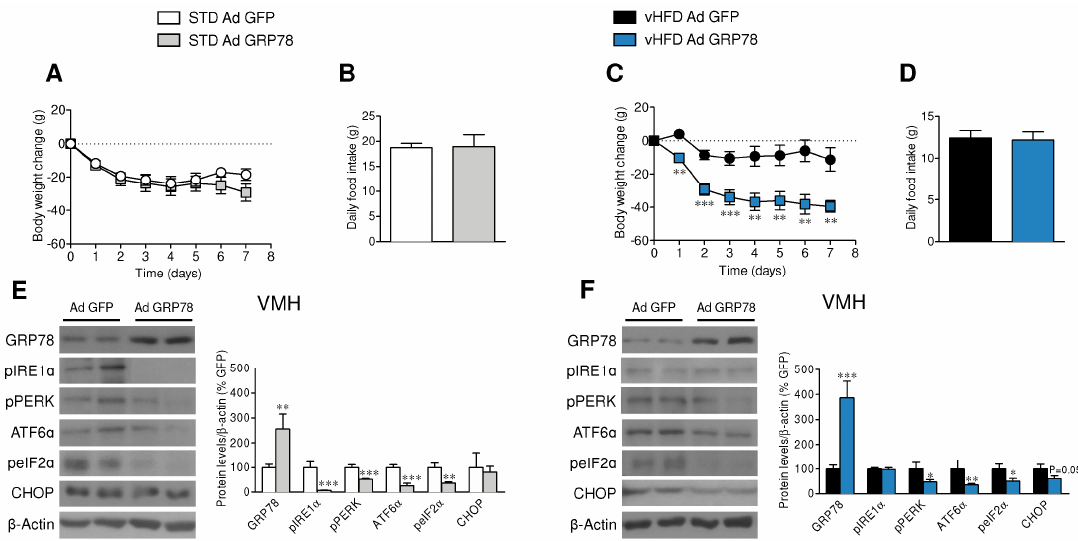
Figure 1. Effect of glucose regulated protein 78 kDa (GRP78) overexpression in the ventromedial nucleus of the hypothalamus (VMH) of very high fat diet (vHFD) rats on energy balance. ( A , C ) Body weight change, ( B , D ) average daily food intake ( n = 9–10 animals per group) and ( E , F ) representative Western blot autoradiographic images and corresponding VMH protein levels of endoplasmic reticulum (ER) unfolding protein response (UPR) pathway ( n = 7 animals per group) of standard laboratory diet (STD) or vHFD rats stereotaxically treated with green fluorescence protein (GFP) or GRP78 adenoviruses into the VMH. Statistical significance was determined by t -Student test. Error bars represent the SEM. * p < 0.05, ** p < 0.01 and *** p < 0.001 vs. (STD or vHFD) Ad GFP. For the Western blot analysis, representative images for all proteins are shown; in the case of the loading controls a representative gel is displayed, although each protein was corrected by its own internal control ( β -actin). In the gel images, all the bands for each picture come always from the same gel, but they may be spliced for clarity.